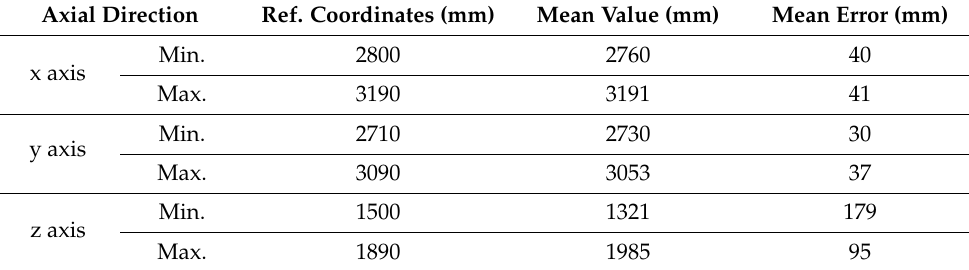
Table 3. Measurement data of orthogonal reciprocating motion using testbed.